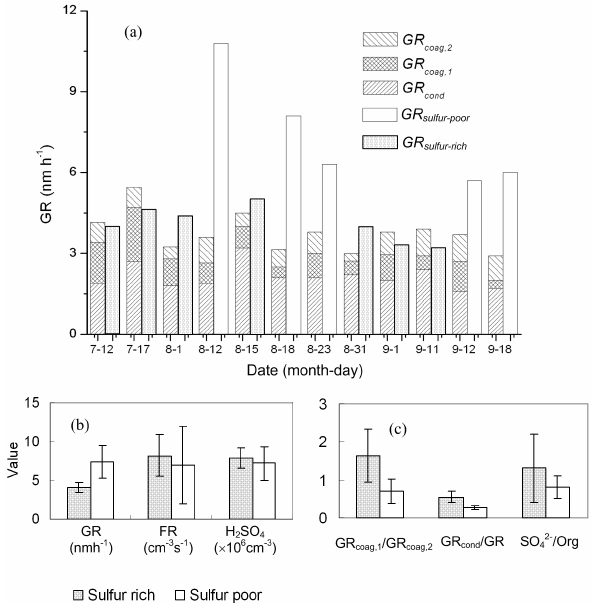
Fig. 3. Apparent growth rates of NPF events and the growth rates caused by the three different mechanisms (a) and comparison of im- portant parameters (b, c) during the two types of NPF events. GR means growth rate; GR cond is the growth rate caused by the conden- sation and neutralization of sulfuric acid; GR coag , 1 and GR coag , 2 are the intramoal coagulation growth rate and extramodal coagu- lation growth rate, respectively. SO 2 − and Org are mass concen- 4 trations of sulfate and organic compounds in 40–400nm particles,